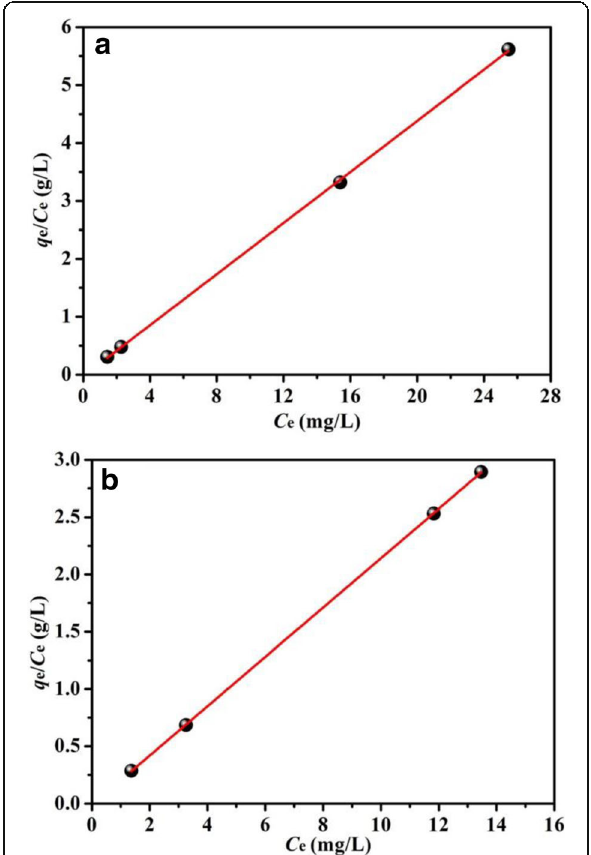
Fig. 11 Langmuir isotherm for adsorption RhB on BiOCl ( a ) and Fe/BiOCl ( b